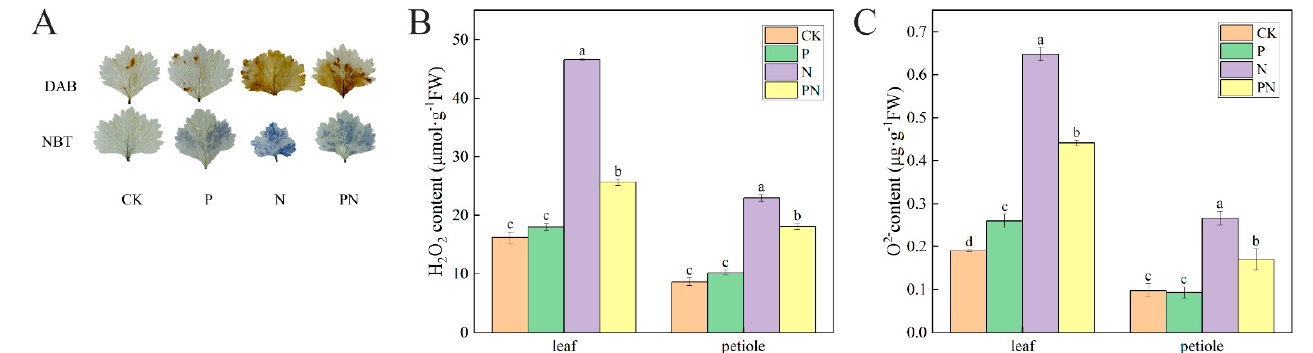
Figure 7. Effect of proline on O 2- and H 2 O 2 accumulation in celery under salt stress. After planting the 35-day-old seedlings for 7 days, they were treated with 0.3 mM proline solution for 7 days, after which they were watered with 100 mM NaCl solution thrice every 3 days. ( A ) Diaminobenzidine (DAB) staining, nitro blue tetrazolium (NBT) staining. ( B ) H 2 O 2 content. ( C ) O 2- content. CK, control. P, 0.3 mM proline. N, 100 mM NaCl. PN, 100 mM NaCl+ 0.3 mM proline. The results are expressed as the mean ± SE of three replicates, and the different letters denote the significant difference among treatments ( p < 0.05), according to Duncan’s multiple tests.